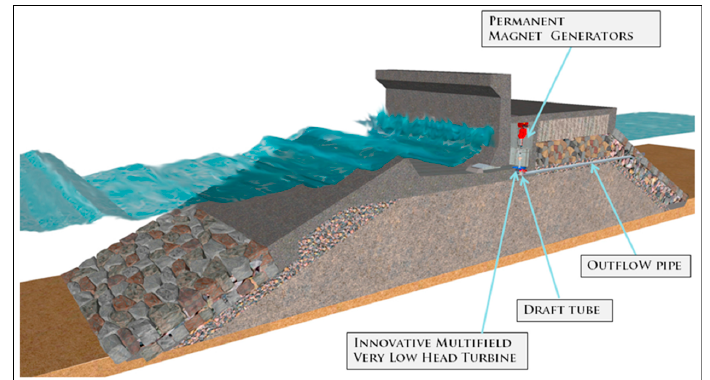
Figure 2. OBREC working principle [21].